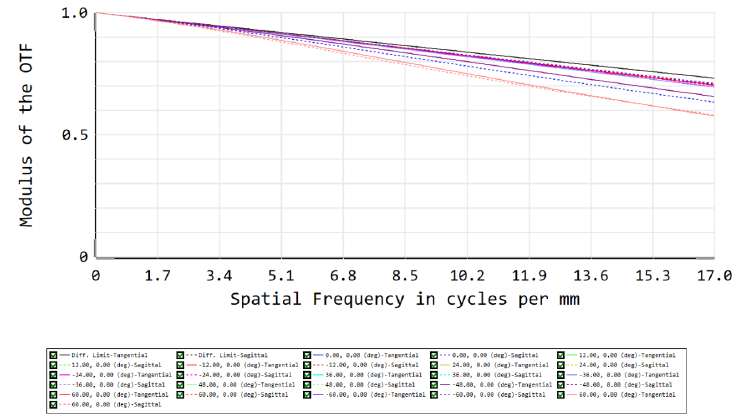
Figure 11. Modulation transfer function (MTF) at 1700 nm and at 17 cycles per mm over the full field of view, corresponding to the use of 2 × 2 pixels to image a spot of 30 µm in diameter. The MTF exceeds 0.5, which indicates an image quality limited by the detector, rather than by the optics. The different colors correspond to the different fields listed in Table